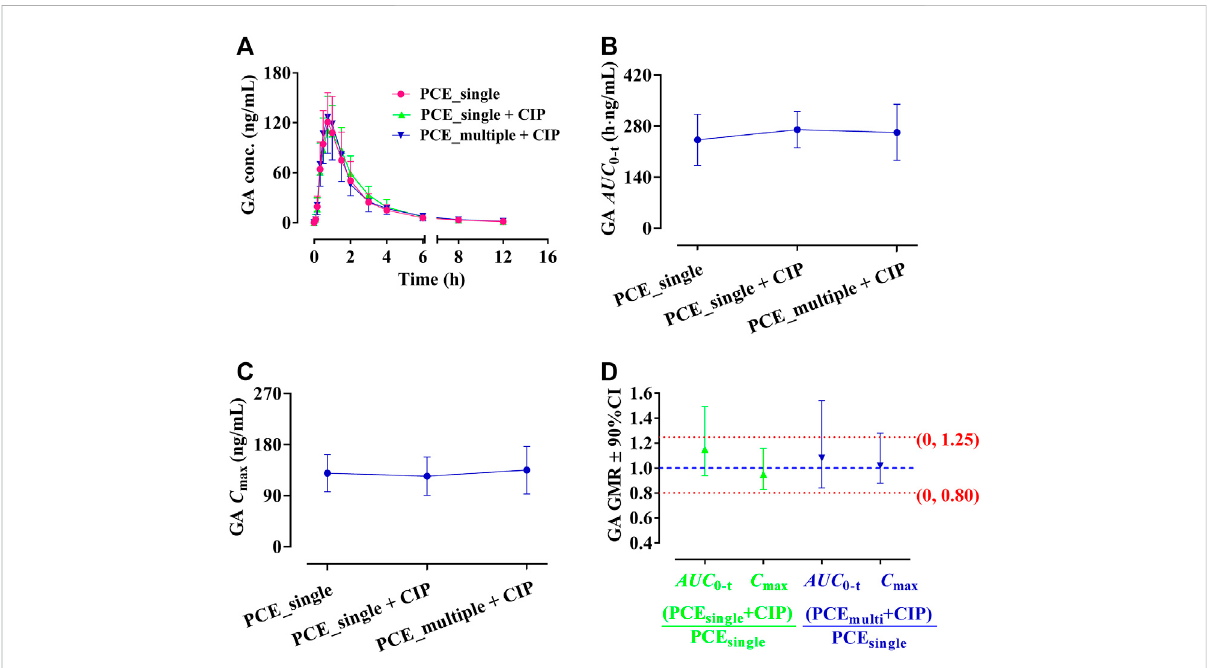
FIGURE 3 Plasma gallic acid (GA) concentration-time pro fi les (A) , the systemic exposure parameters of GA including AUC 0-t (B) and C max (C) , and their 90% CIs for the geometric mean ratios [GMR, (D) ] in the presence and absence of oral cipro fl oxacin hydrochloride tablets (CIP) to healthy humans (mean ± SD, n =